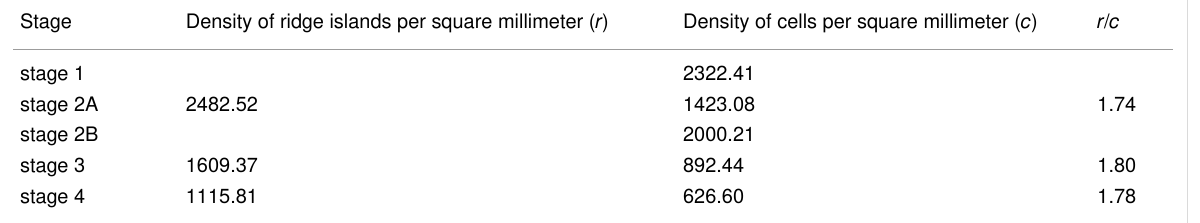
Table 2: The variation in the density of cells and ridge islands (as number of cells per square millimeter) with leaf growth.